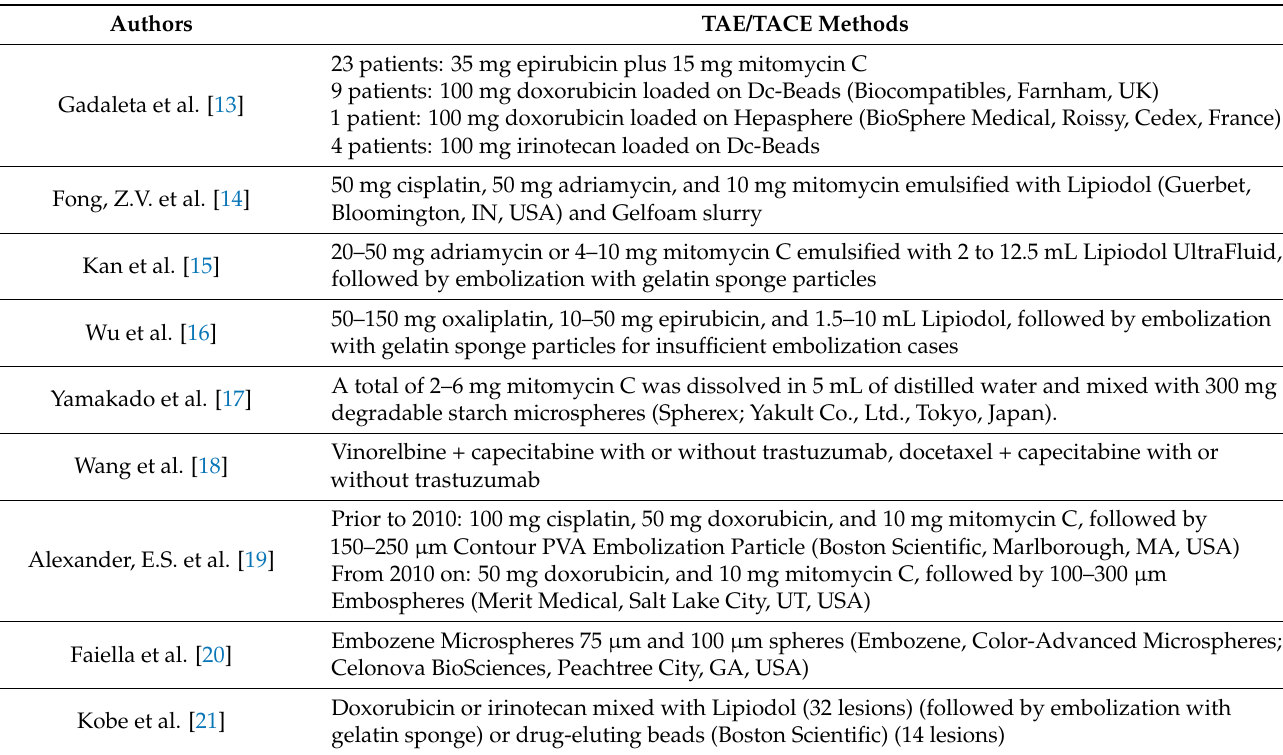
Table 3. TAE/TACE methods of the studies included in the